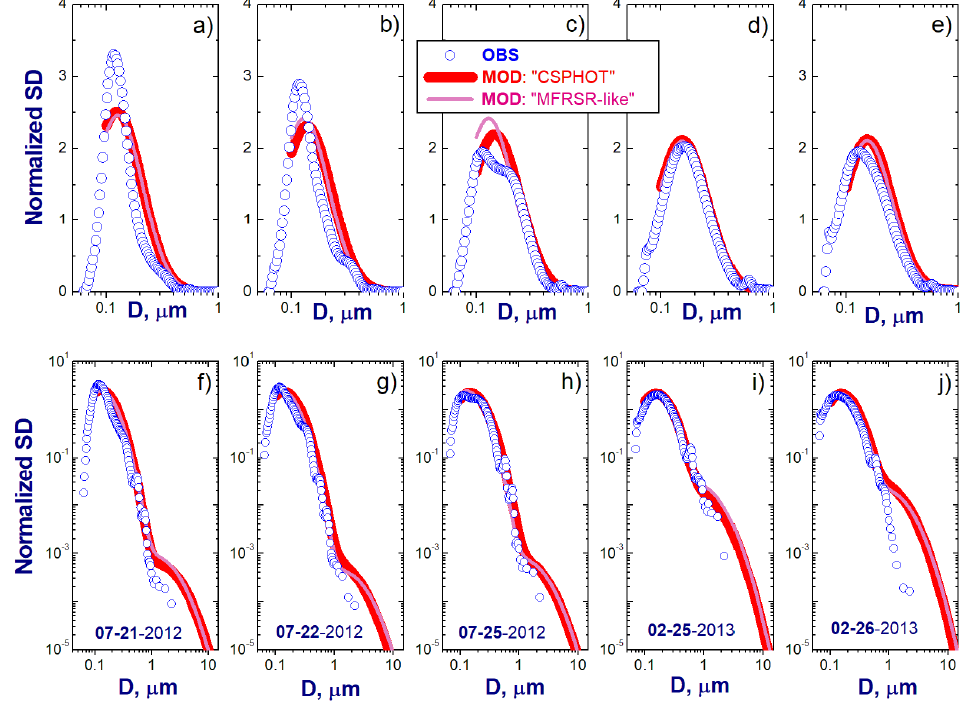
Figure 4. The normalized number SDs obtained from airborne measurements (symbol “obs”) and estimated (symbol “mod”) from the measured AOD and the ambient complex RI (Table 1) for five selected days. The top panel ( a – e ) shows the sub-micron size range, while the bottom panel ( f – j ) describes the entire size range. The model SDs represent the “CSPHOT” and “MFRSR-like” retrieval schemes (Section 2).